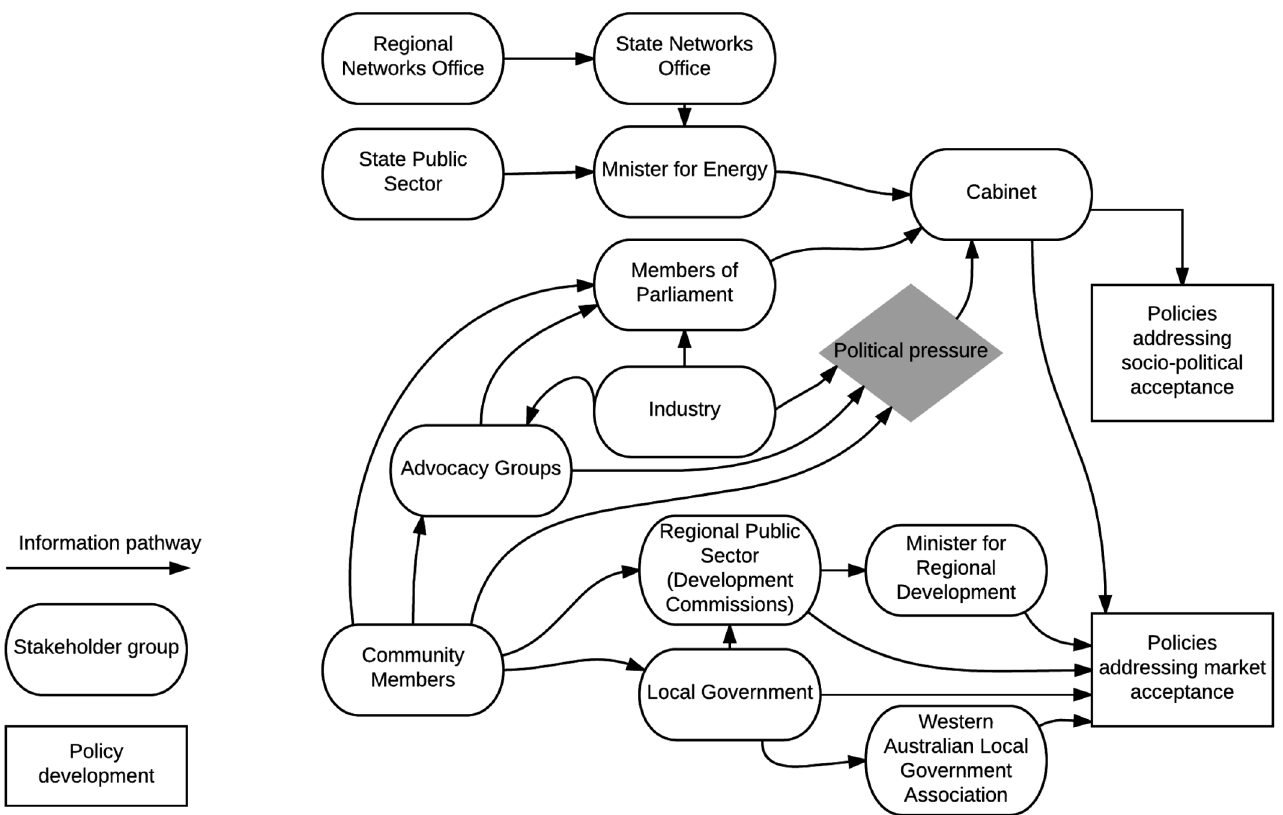
Fig. 2. Network map showing the pathways of policy in fl uence suggested by interview respondents. Arrows represent opportunities for information exchange, however it is only at the point of “ political pressure ” that state government was considered likely to act on advice from